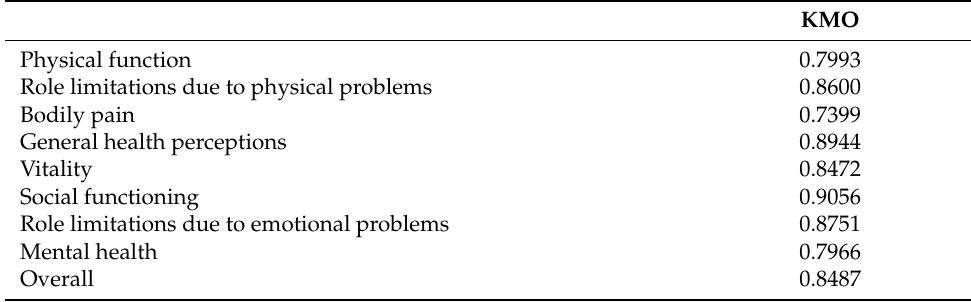
Table A2. Kaiser-Meyer-Olkin (KMO) measure of sampling adequacy.